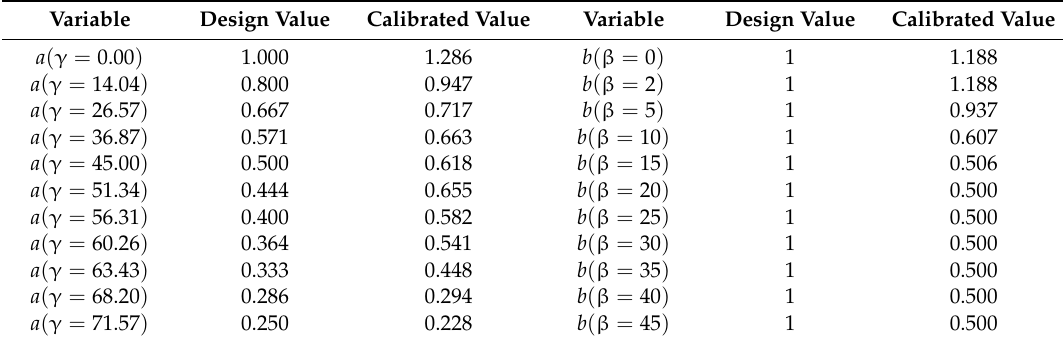
Table 7. Calibration variables related with the initial and the calibrated model.